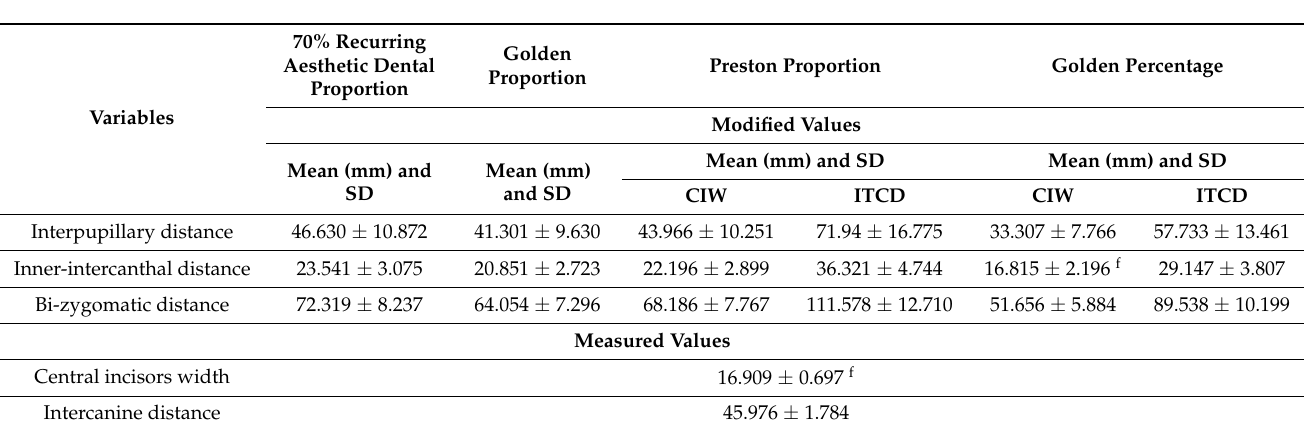
Table 9. The comparison of modified central incisor width and intercanine distance using dental proportion by horizontal facial proportions with measured central incisor width and intercanine distance -male group ( n = 112).